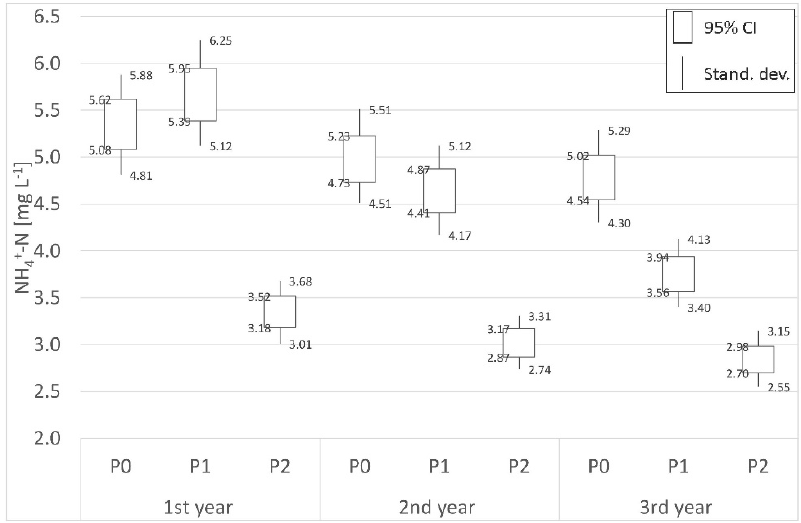
Figure 10. The concentrations of NH 4+ -N in groundwater under peatland soils.